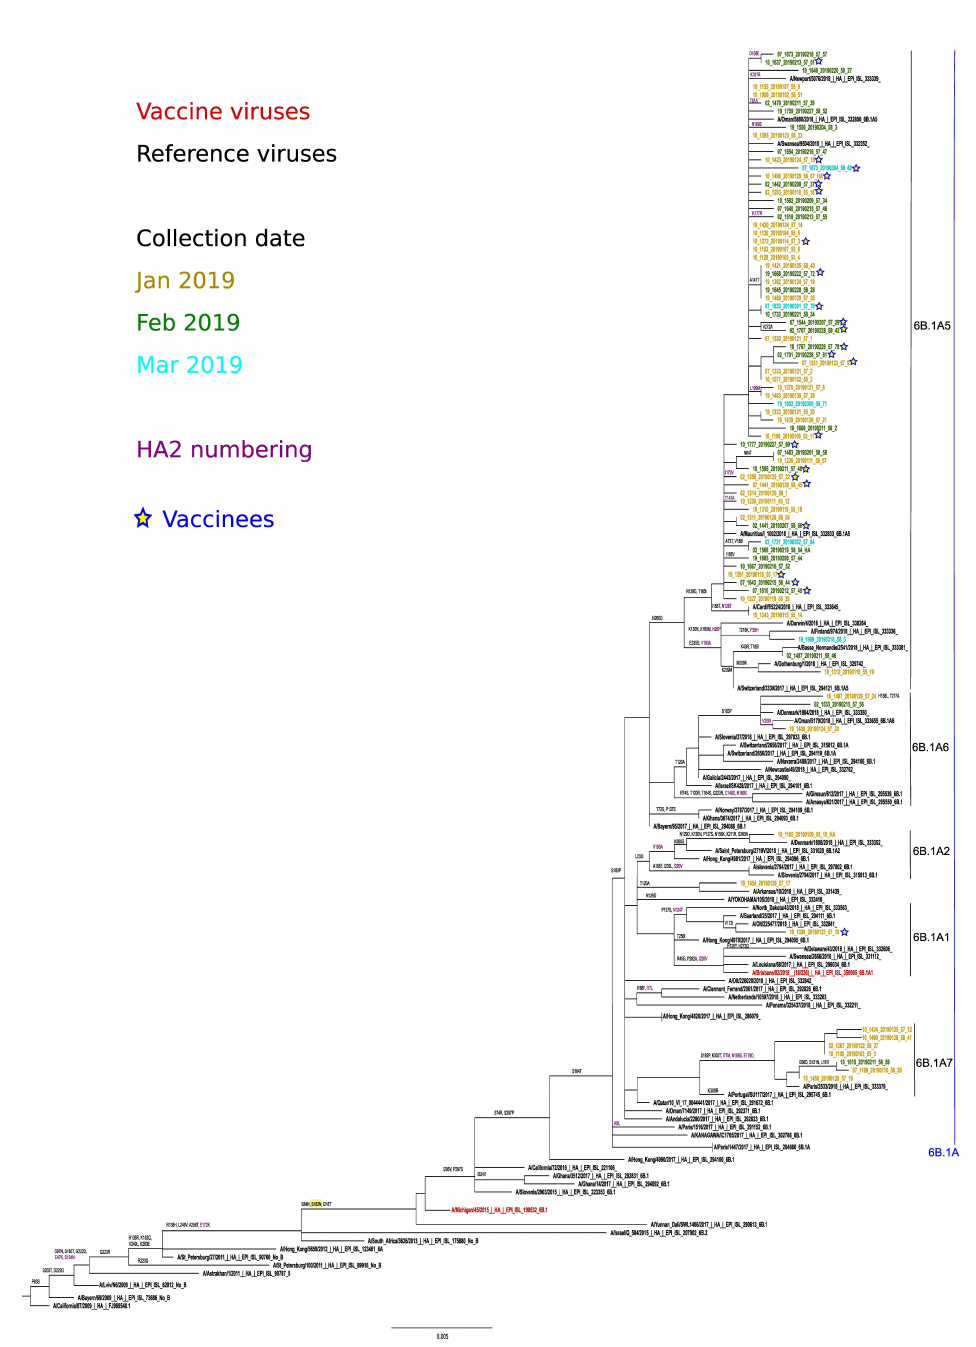
Figure 3. Phylogenetic analysis and mutational profiles for the A/H1N1pdm09 clades and sequenced isolates. Changes potentially gaining a glycosylation site are indicated in yellow. ML tree constructed using RAxML and the GTR-GAMMA substitution